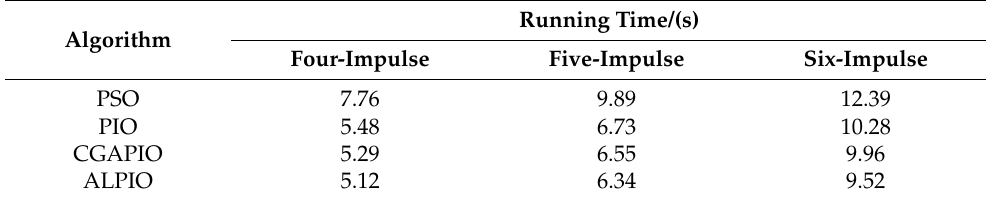
Table 10. Running time of different algorithms at different impulses.